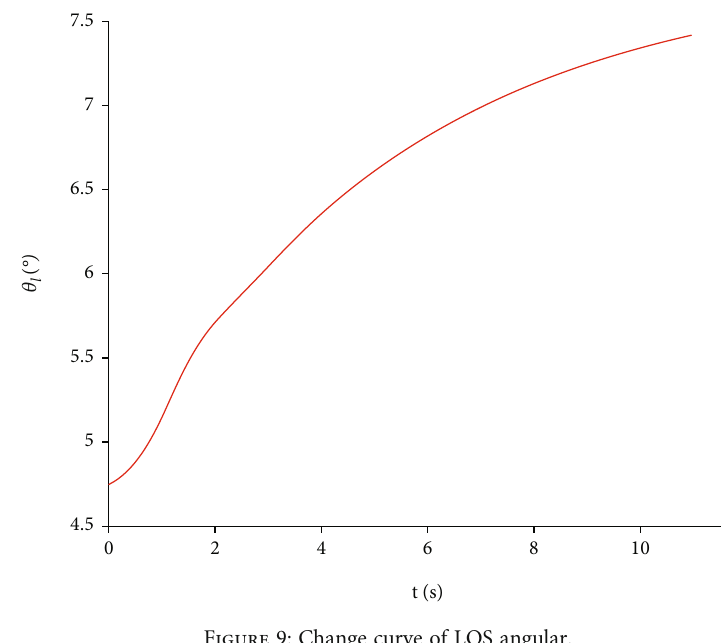
Figure 9: Change curve of LOS